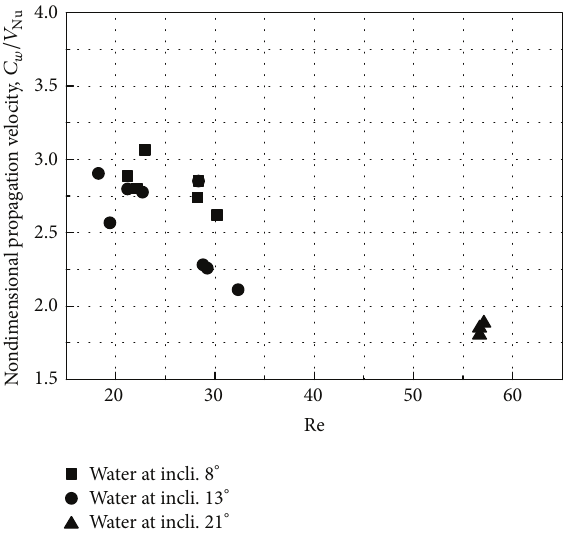
Figure 7: Solitary wave propagation velocity. Reynolds number is the same as that for the Nusselt surface film velocity, causing the ratio to become independent on the Reynolds number.